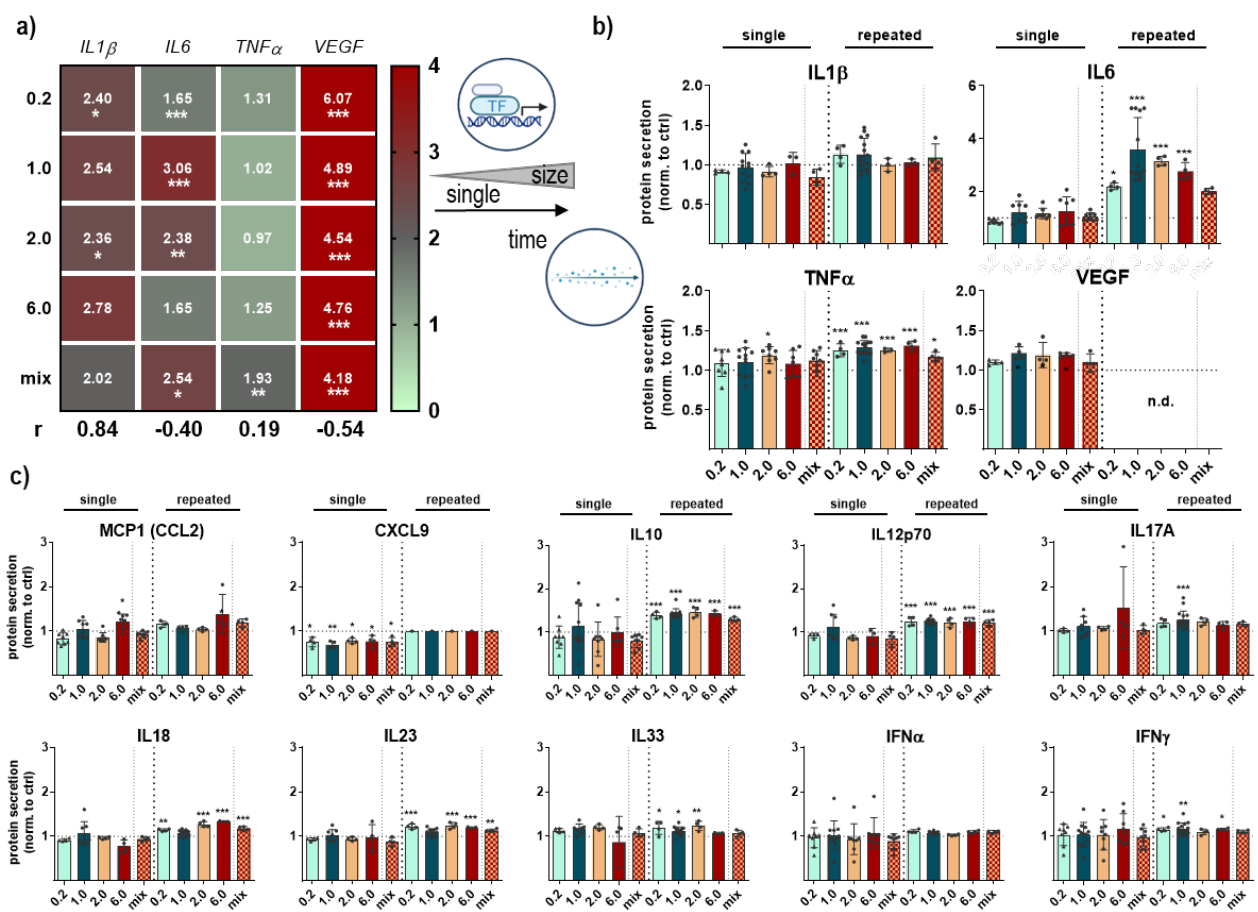
Figure 6. Secretion profiles in NMP-treated lung cells . ( a ) Expression levels of IL1 β , IL6 , TNF α , and VEGF measured using qPCR and shown in a heatmap after single NMP exposure; ( b , c ) multiplex protein release quantification after single and repeated NMP exposure in lung cell supernatants as shown in diagrams. Data were normalized to untreated controls (ctrl) and presented as mean + SE. Statistical analysis was done by unpaired, two-tailed Student ’ s t-test ( n > 6) with * p < 0.05, ** p < 0.01, and *** p < 0.001.